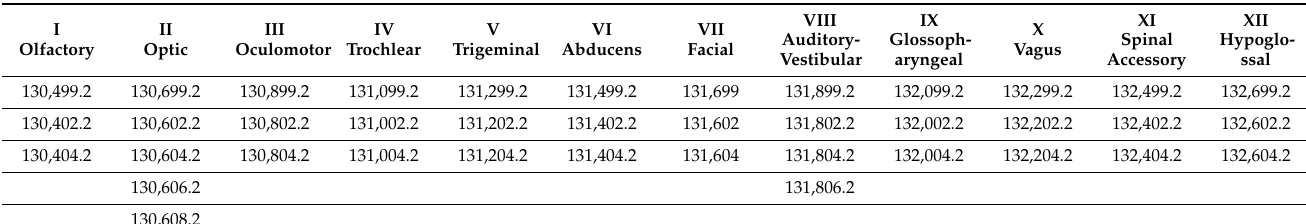
Table 1. AIS codes of cranial nerve injury.